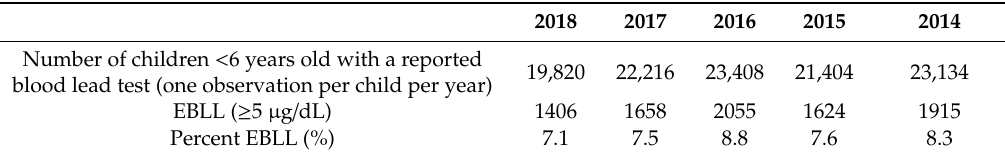
Table 1. Prevalence of elevated blood lead levels in Detroit, 2014–2018.